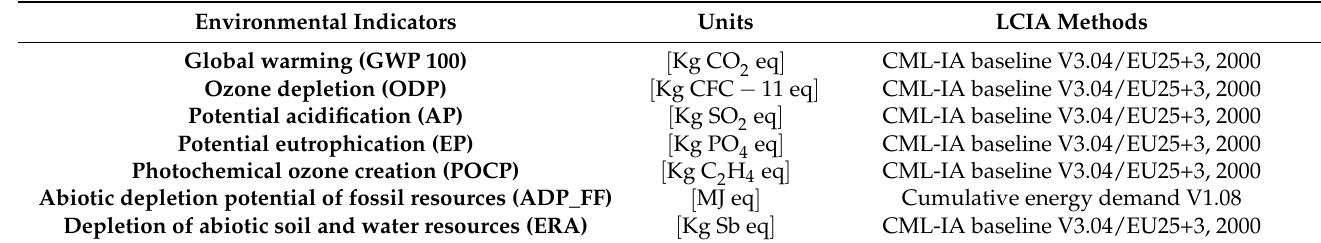
Table 6. Indicators, units, and methods of